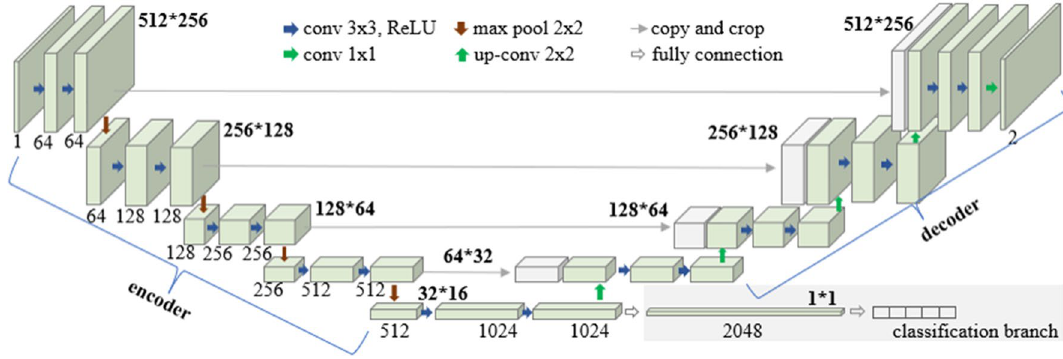
Figure 2. The two-branch network